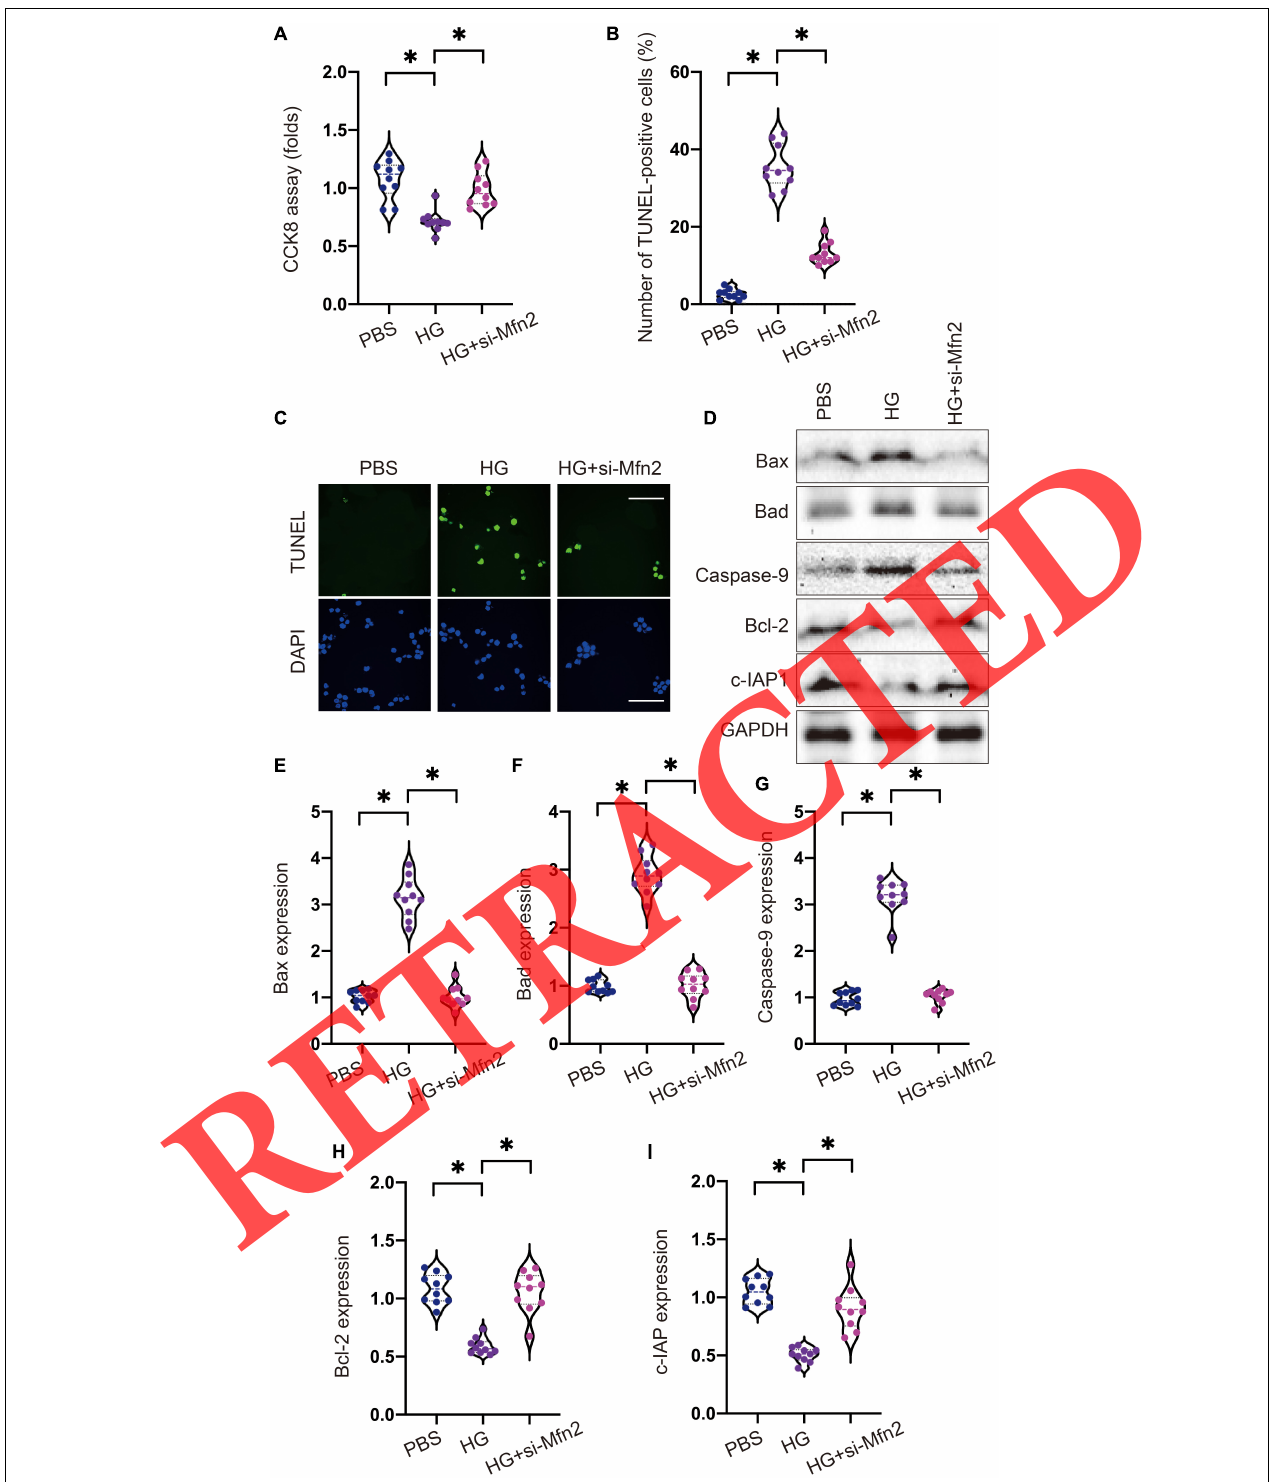
FIGURE 2 | Hyperglycemia activates mitochondrial apoptosis in cardiomyocytes through Mfn2. (A) A CCK-8 assay was used to observe the changes in cardiomyocyte viability in response to Mfn2 silencing under hyperglycemic conditions. (B,C) TUNEL staining was used to determine the number of apoptotic cardiomyocytes in response to Mfn2 silencing under hyperglycemic conditions. (D–I) Proteins were isolated from hyperglycemia-treated cardiomyocytes, and Western blotting was used to analyze the expressions of mitochondrial apoptotic proteins. ∗ p < 0.05.